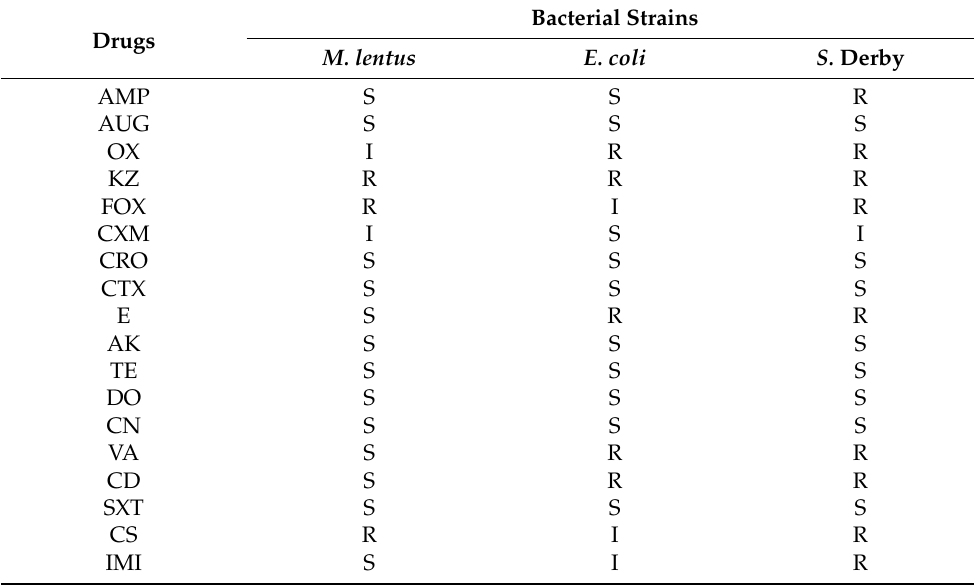
Table 1. Antimicrobial resistance profiles of strains isolated from poultry litter. Bacterial Strains Drugs M.